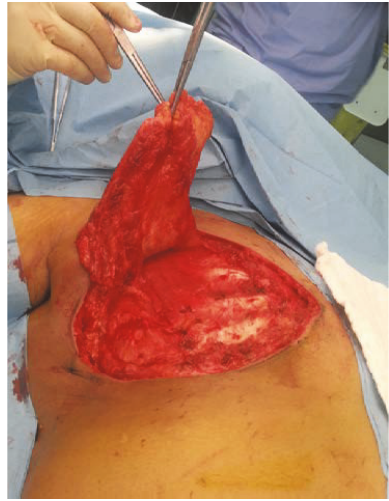
Figure 3: Intraoperative picture of the resected